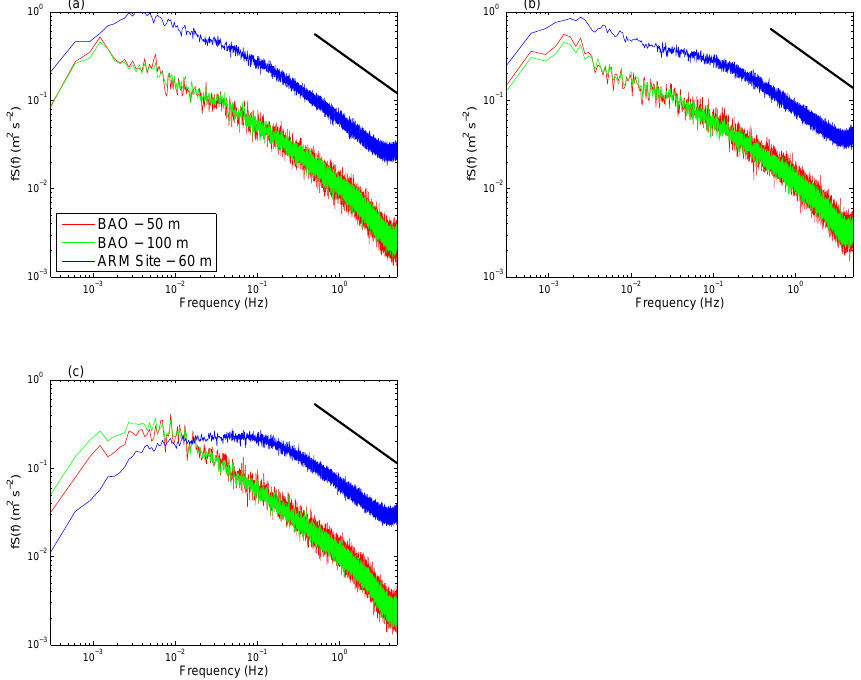
Figure 11. Averaged (a) u spectra, (b) v spectra, and (c) w spectra for unstable conditions measured by the south BAO sonic at 50 and 100m and the ARM sonic at 60m. Black line denotes theoretical − 2 / 3 slope for inertial subrange. Note the larger amount of energy contained at the lowest frequency scales at the BAO for the w component at both measurement